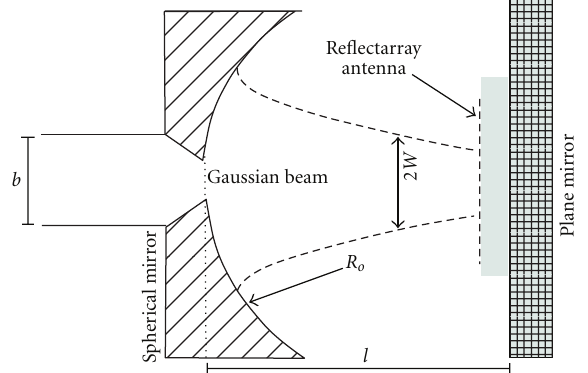
Figure 3: Open resonator system for reflectarray elements charac- terization.